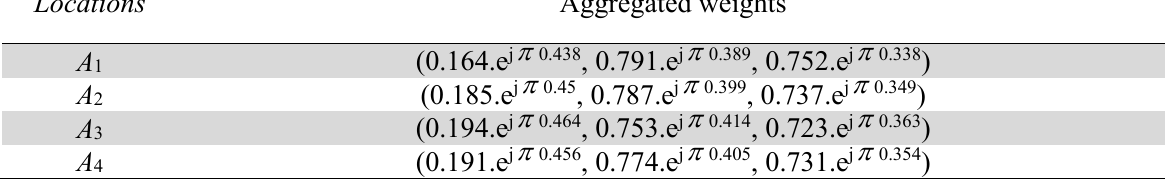
The final evaluation values of each